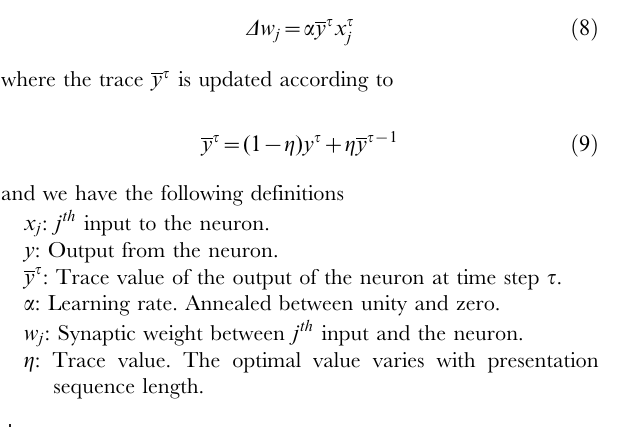
Table 3. Sigmoid